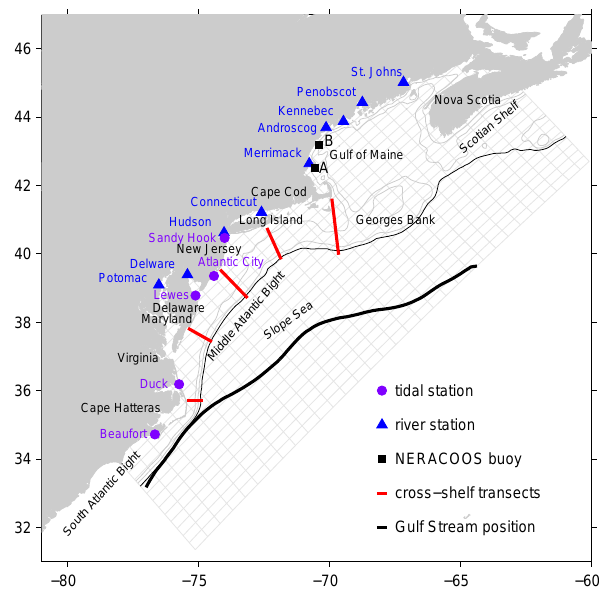
Figure 1. The MABGOM model grid (light gray, plotted every five grid points) and locations of coastal sea level stations (purple cir- cle), USGS river gauges (blue triangle), NERACOOS buoys (black square), and cross-shelf transects (red line) where the circulation was sampled, as discussed in Sect. 3.2.2. The black dashed line denotes the mean path of Gulf Stream, determined by the 15 ◦ C isotherm at 200m (Joyce et al., 2000). The 50 and 100m isobaths are shown in light gray, and the 200m isobath is plotted in black. Geographic locations discussed in the text are also